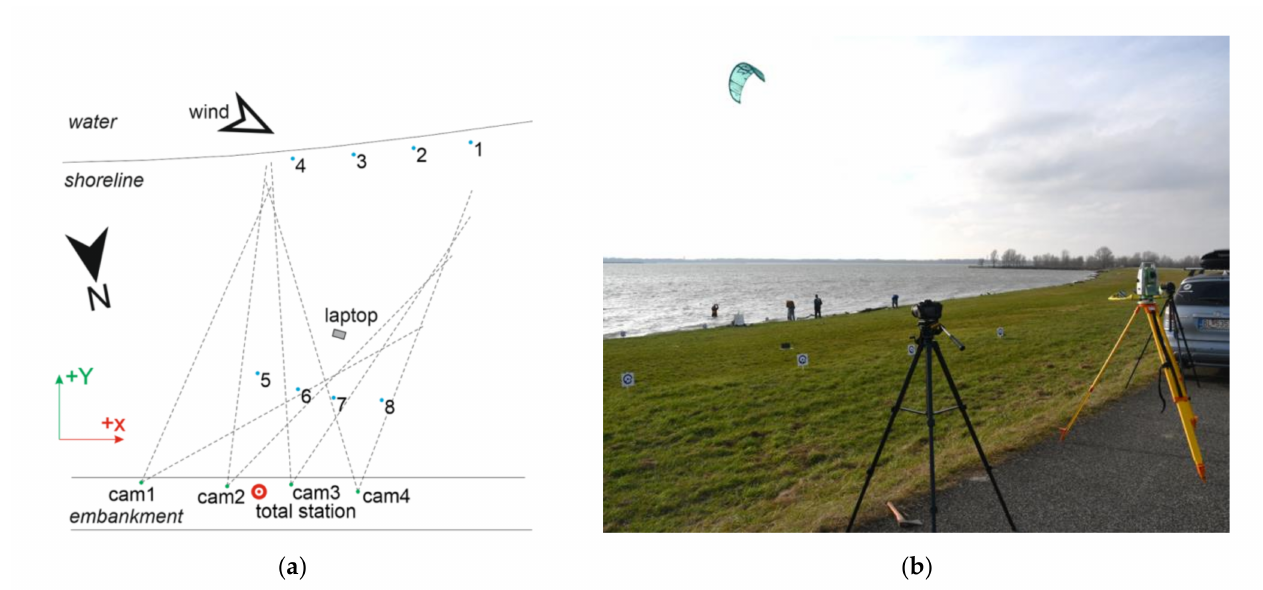
Figure 2. ( a ) Plan of the placement of cameras and GCPs; ( b ) Shore conditions during the experiment. The video was recorded at 4K resolution with a frequency of 30 fps. We captured 4 × 24 GB of data from all cameras (approximately 4 × 30 min of video). The synchronisa- tion of individual video recordings was ensured by means of a timer running on a laptop screen in the field of view of all cameras (Figure 3a,b). The cameras and wearable sensors had differing starting times. Therefore, it was necessary to determine the time discrepancy between the two measurement methods. This was accomplished by visual comparison of the data based on the size of the jumps and the time differences between them.